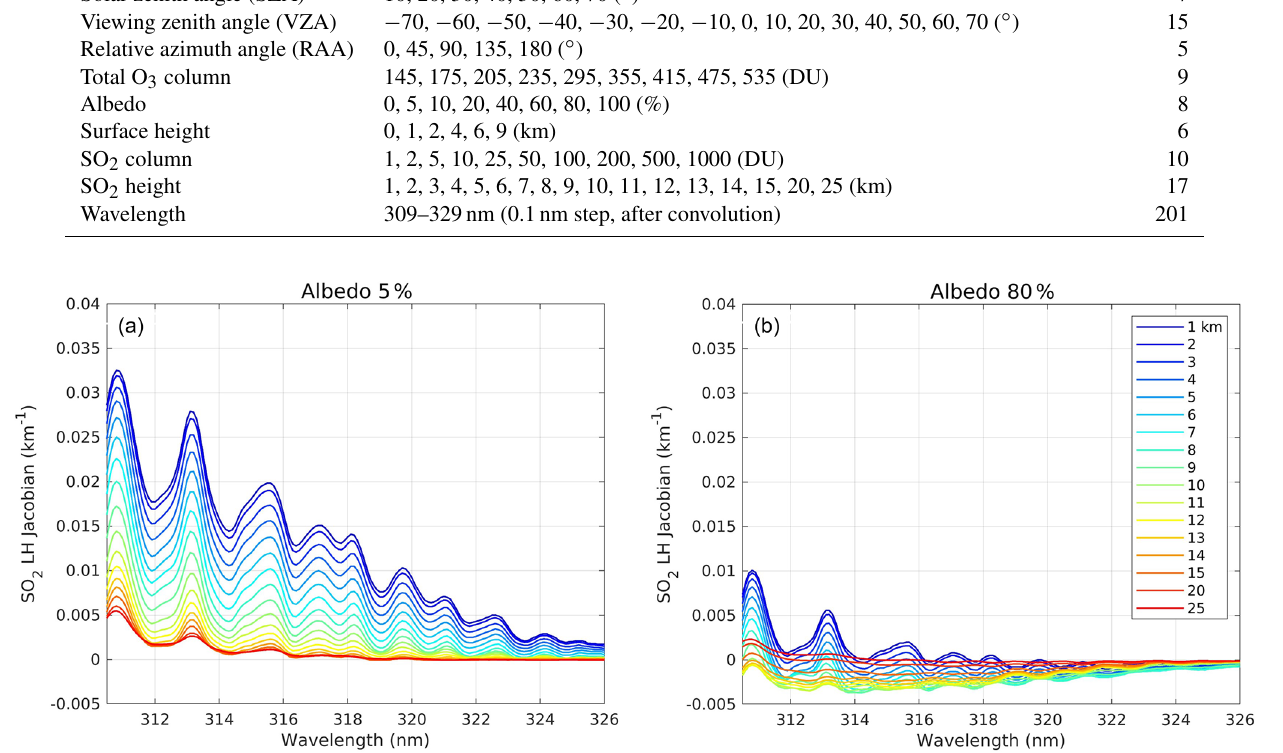
Figure 1. Examples of SO 2 optical depth Jacobians with respect to LH for different SO 2 peak heights (1–25km), and LER albedos of 5% (a) and 80% (b) . The spectra correspond to SZA: 30 ◦ , VZA: 0 ◦ , RAA: 0 ◦ , SO 2 column: 25DU, ozone column: 295DU, surface height: